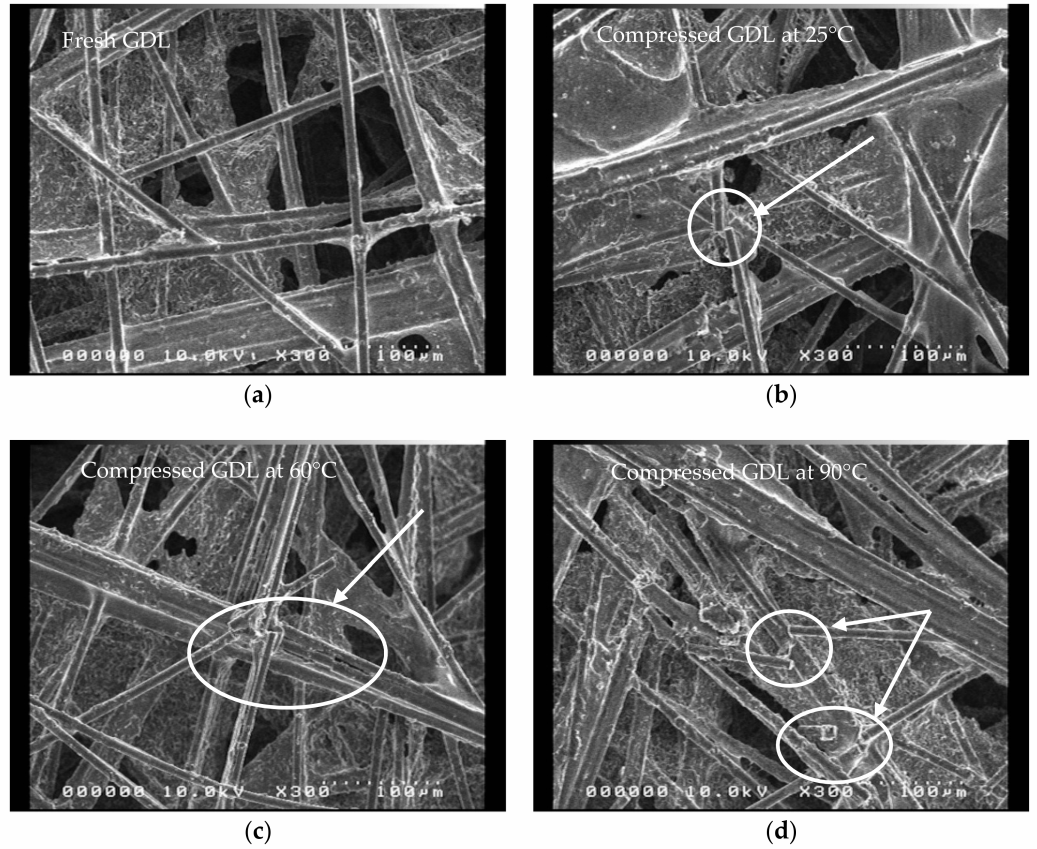
Figure 5. SEM micrographs of ( a ) uncompressed GDL; ( b ) compressed GDL at 25 ◦ C; ( c ) compressed GDL at 60 ◦ C; and ( d ) compressed GDL at 90 ◦ C (Carbon fibers breakage is highlighted with circles as the arrows